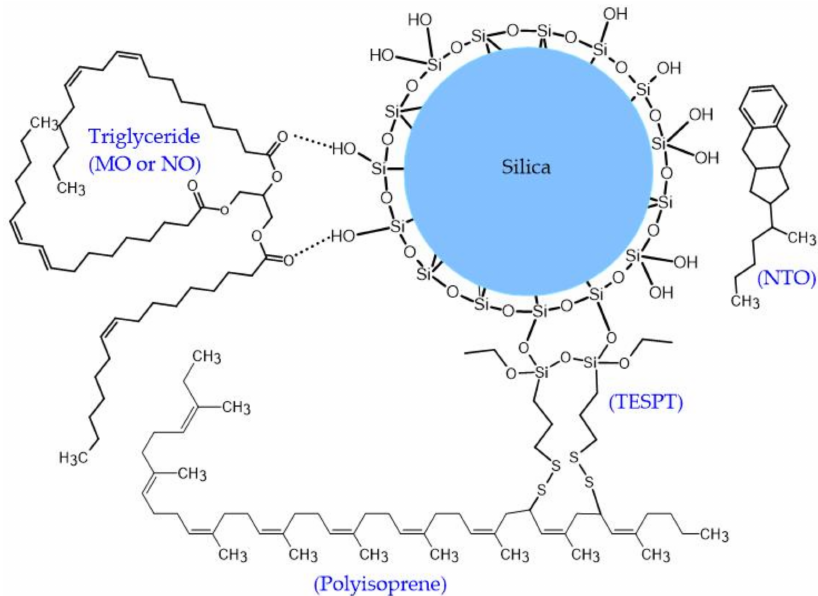
Figure 5. Proposed model illustration of the imaginable formation of hydrogen bonding between vegetable oils (MO and NO) and